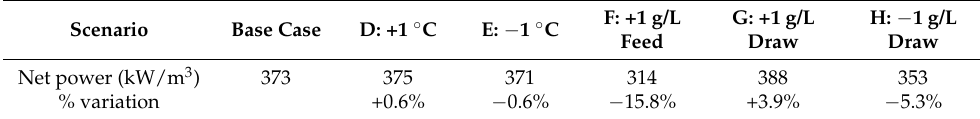
Table 4. Sensitivity analysis for the net